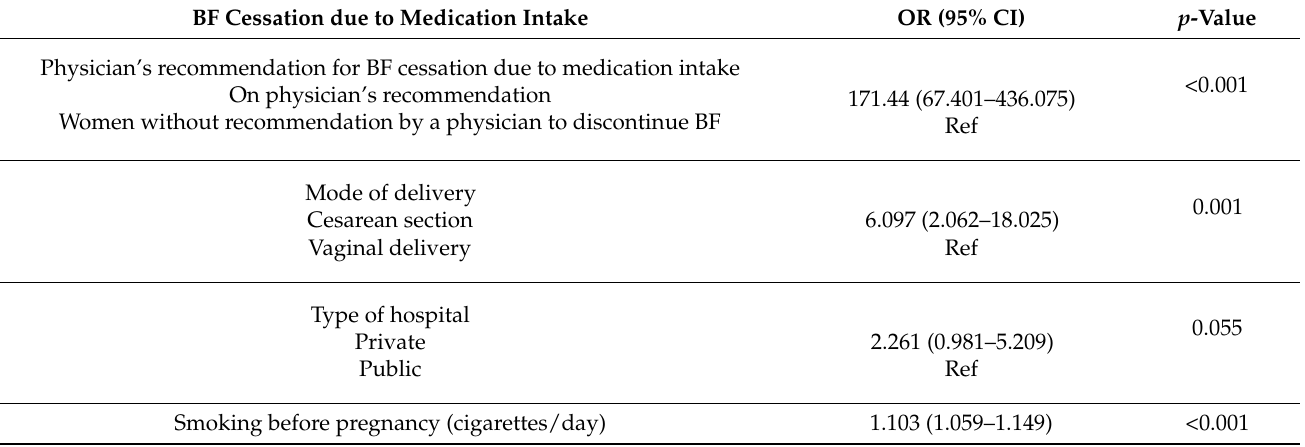
Table 2. Multiple logistic regression analysis for breastfeeding cessation due to medication intake. (Attica/Greece 2020; n =